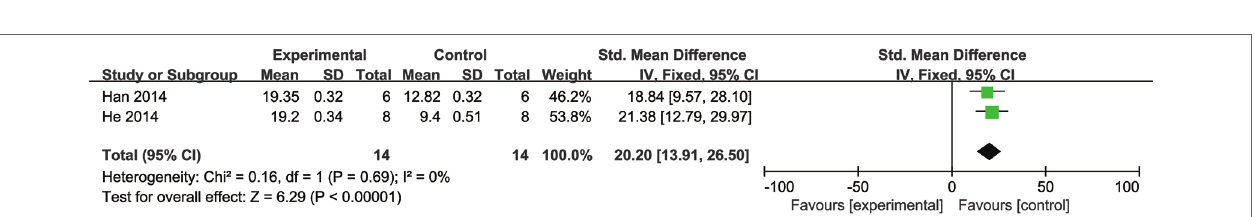
Frontiers in Pharmacology |